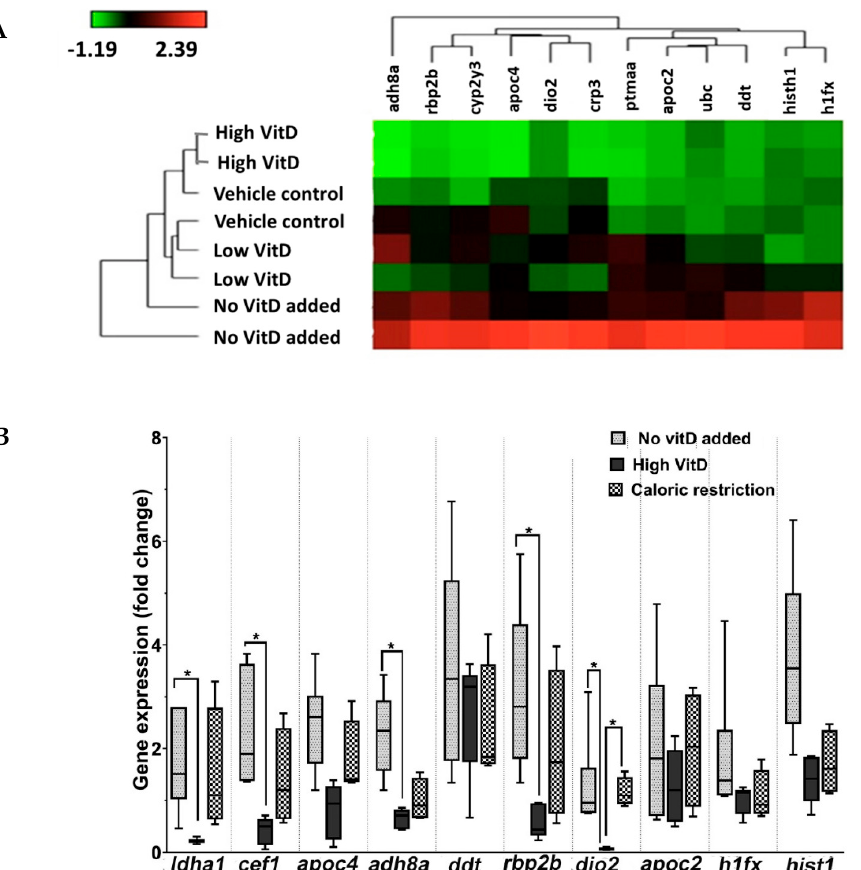
Figure 3. RNA sequencing and validation of the top genes by RT-qPCR in NAFLD zebrafish supple- mented with VitD. ( A ) Heat map of top differentially expressed protein-coding genes. The expression of 12 genes was downregulated significantly in high VitD-supplemented as compared to NAFLD group (FDR-adjusted p < 0.05). ( B ) Gene expression by RT-qPCR in NAFLD, NAFLD plus high VitD, and caloric restriction groups. * p <